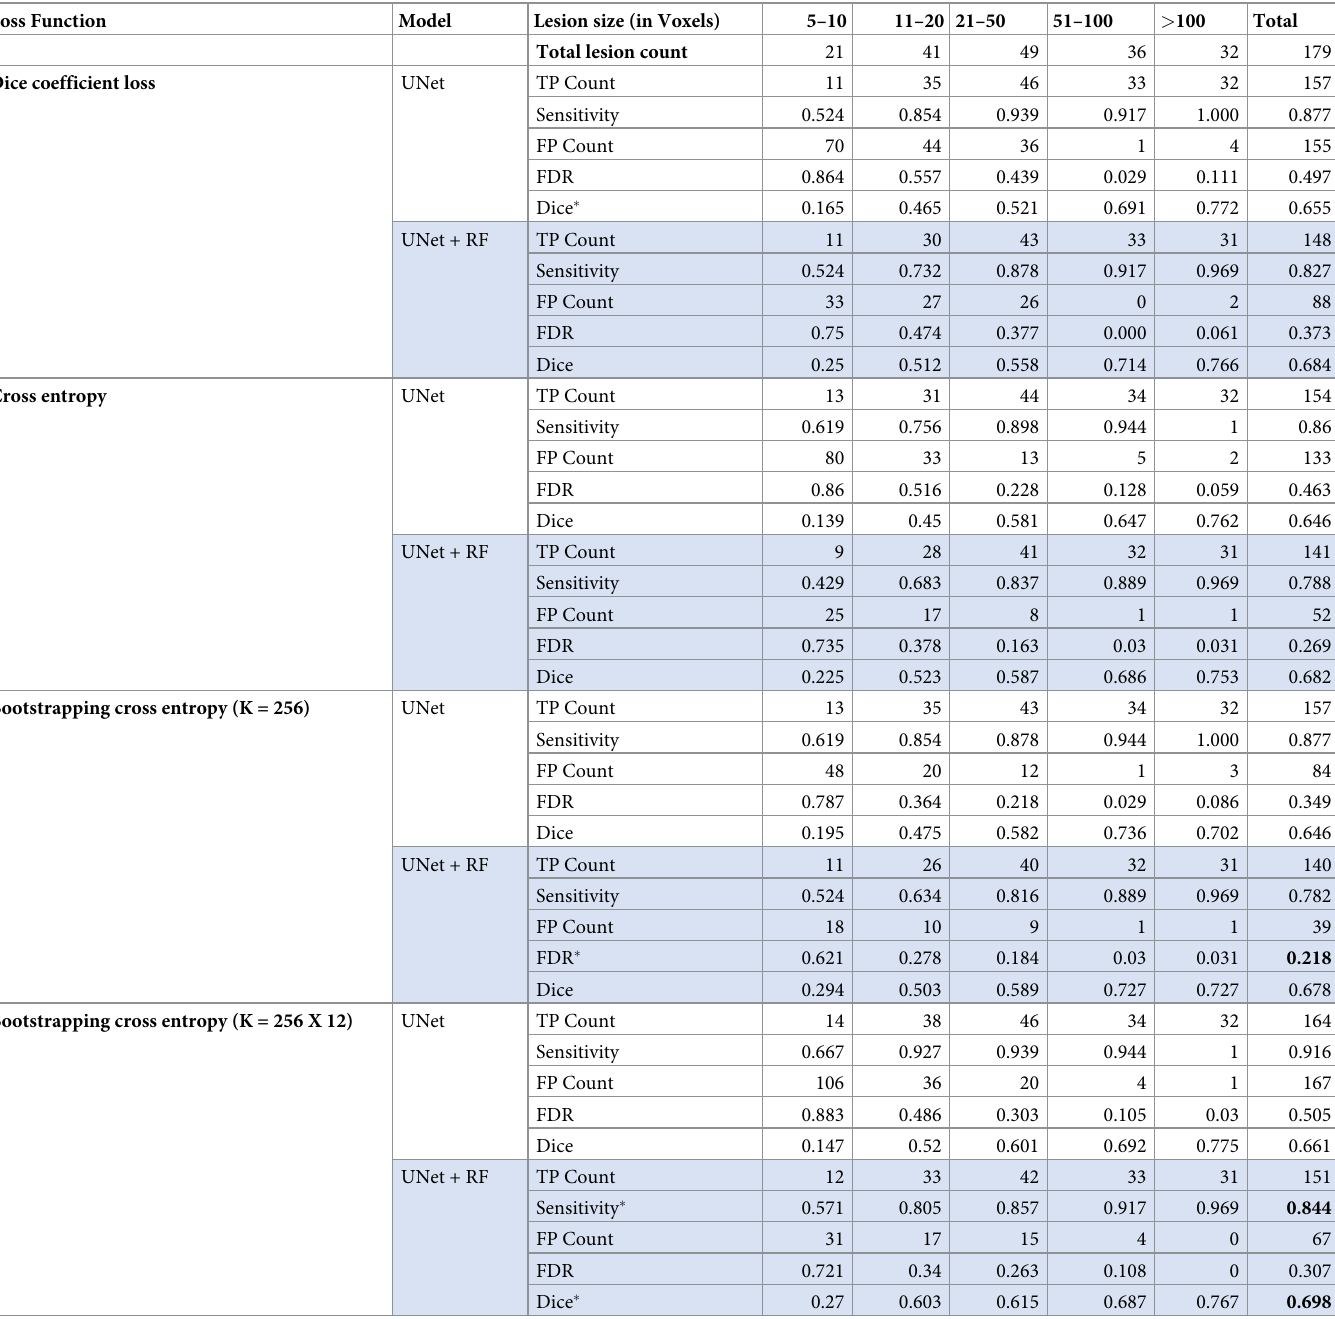
Table 3. Model performance for test cases of Dataset A with different loss